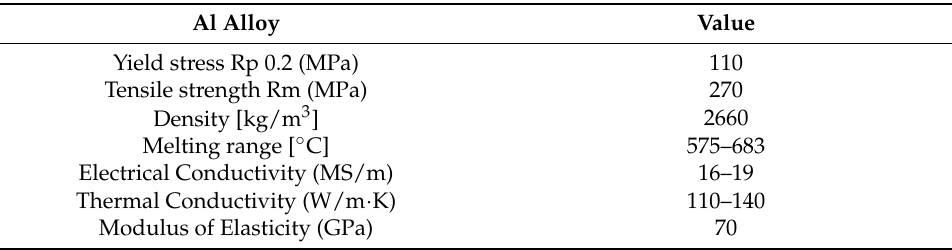
Table 4. Physical and mechanical properties of aluminum alloy AW 5083 [16].